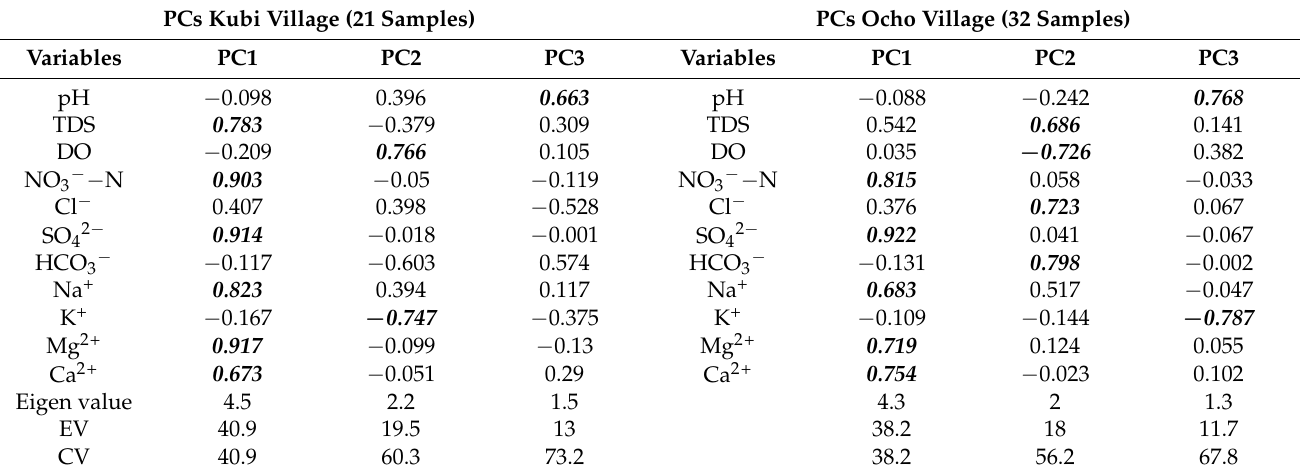
Table 2. Principal component (PC) loadings of 11 chemical variables for groundwater samples in Kubi and Ocho